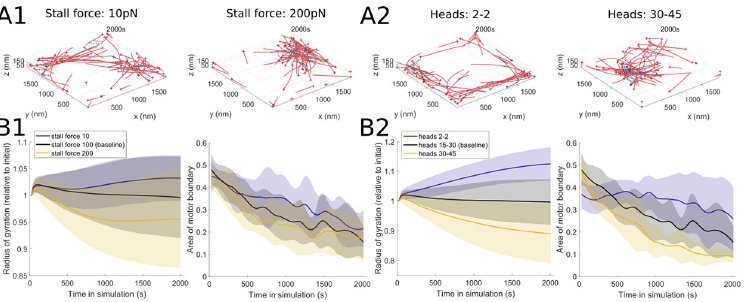
Fig 7. Increasing motor protein stall force and number of heads per minifilament results in clustered actin filaments. (A) Final simulation snapshots ( t = 2000s) for different myosin stall forces ((A1): 10pN and 200pN) and different ranges of numbers of heads ((A2): minimum of 2 to maximum of 2 (2–2), and minimum 30 to maximum 45 (30–45)). (B) Characterizing the actin and myosin time-series organization through radius of gyration and spatial distribution of motor proteins in simulations with varying myosin stall forces (B1) and different ranges of numbers of heads (B2). Both measures decrease as the stall force or number of heads increases, visually consistent with the increased clustering in the simulations. Unless otherwise indicated above, the parameter values used are d step = 6 nm, k head,bind = 0.2/s, F s = 100 pN, range heads = 15–30 (see Table 1). Solid lines indicate the average and shaded areas indicate the standard deviation over 10 stochastic runs. See Fig 3 for additional measure